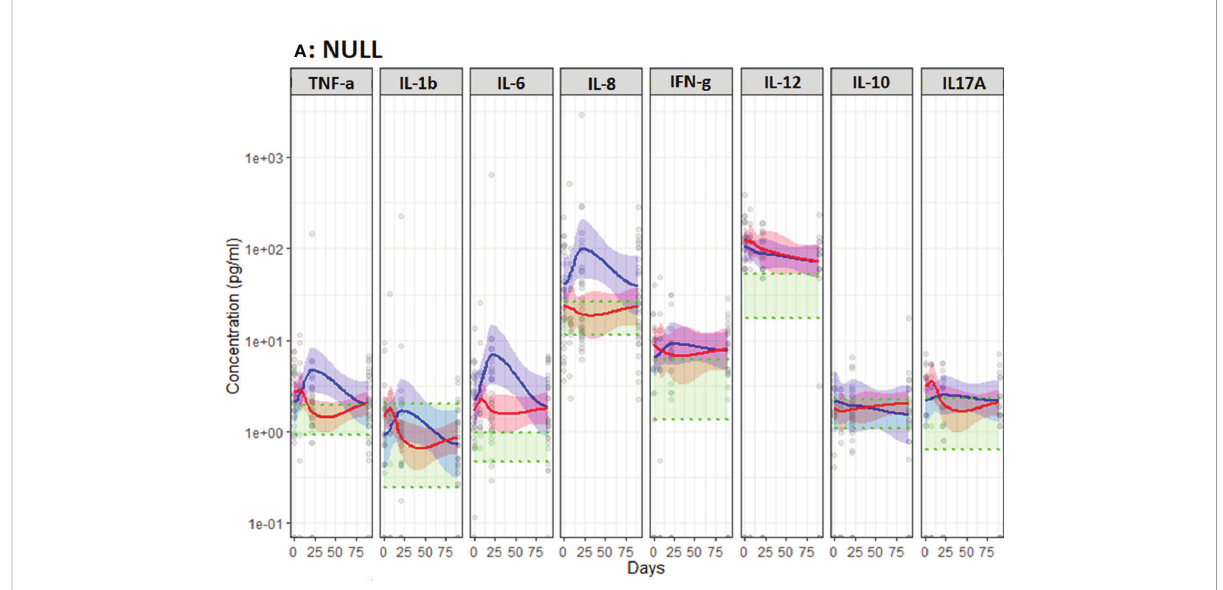
FIGURE 4 Unstimulated immune response assessed by TruCulture ® (NULL) in NSCLC patients during treatment with either CT (Red, n=24) or ICI (Blue, n=13). Corresponding 95% con fi dence interval shown as the light red respectively blue area. The shaded green area represents the in-house reference level (95% con fi dence interval between the green dotted